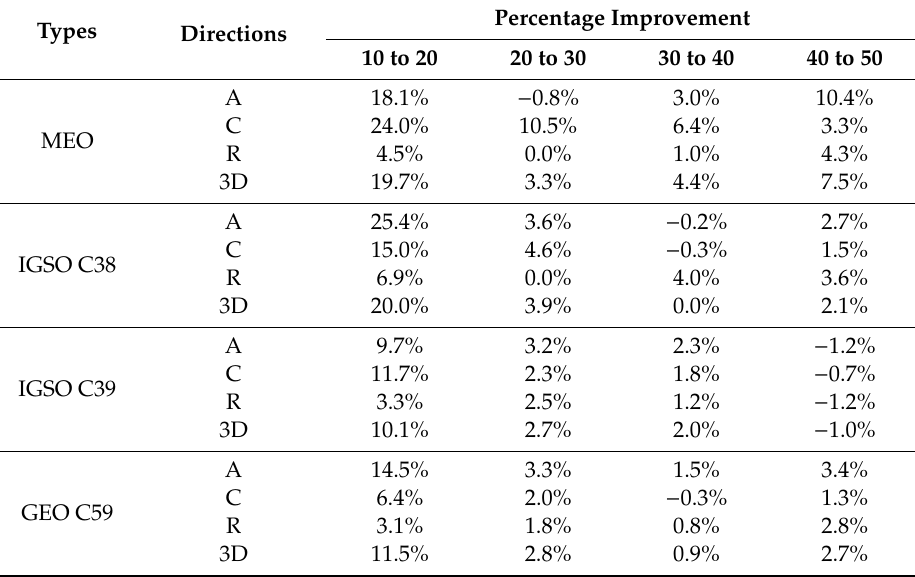
Table 4. Percentage improvement when increasing the number of tracking